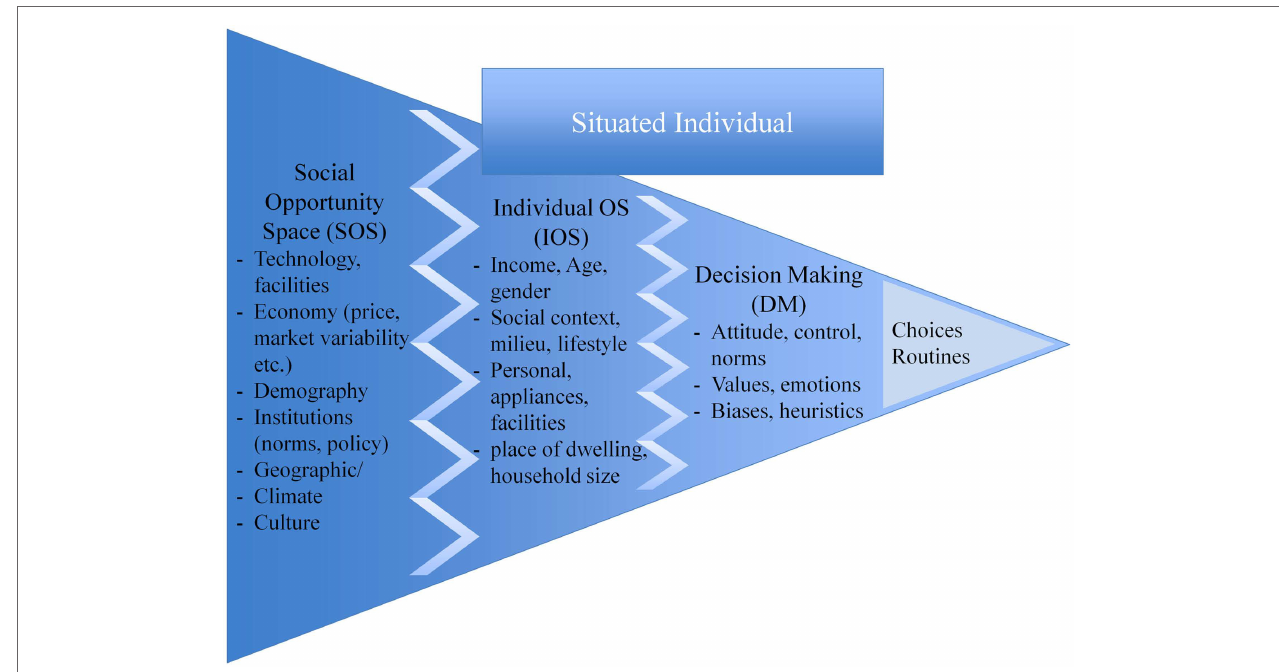
FiGUre 4 | explanantia – determinants of eCB and its change